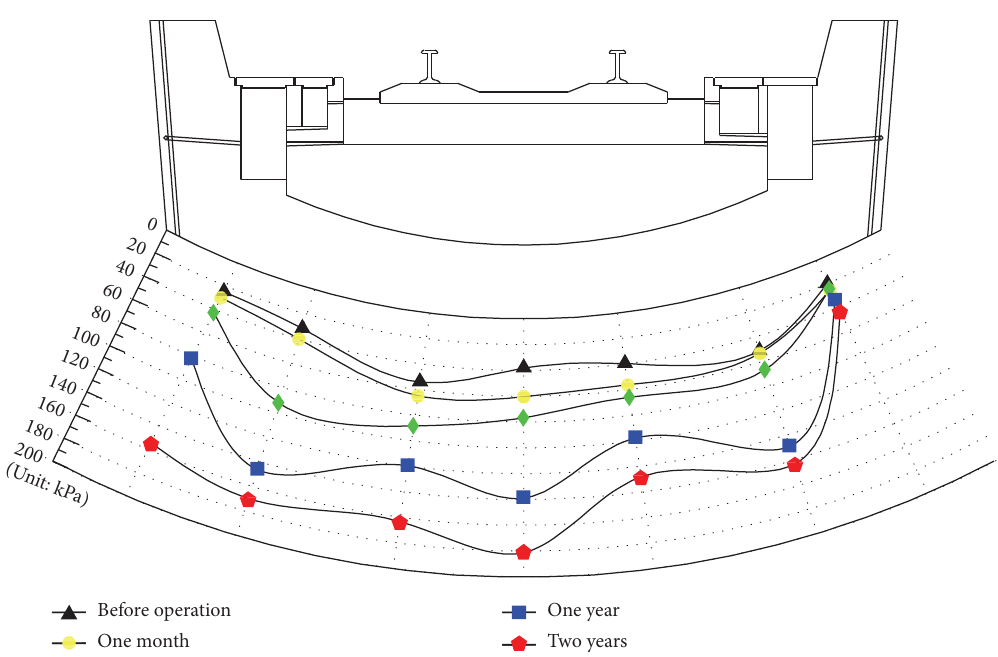
Figure 7: Earth pressure change diagram of surrounding rock at the